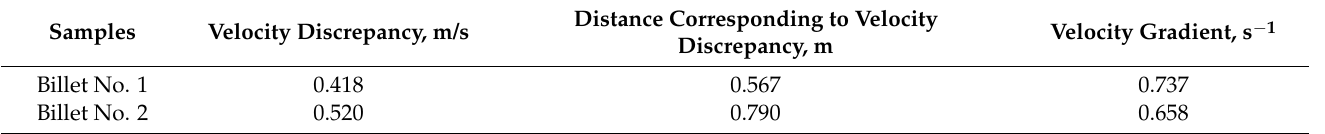
Table 7. Velocity discrepancy and gradient of molten steel when the velocity decreases to 0.193 m/s. Distance Corresponding to Velocity Samples Velocity Discrepancy, m/s Velocity Gradient, s − 1 Discrepancy, m Billet No. 1 0.418 0.567 0.737 Billet No. 2 0.520 0.790